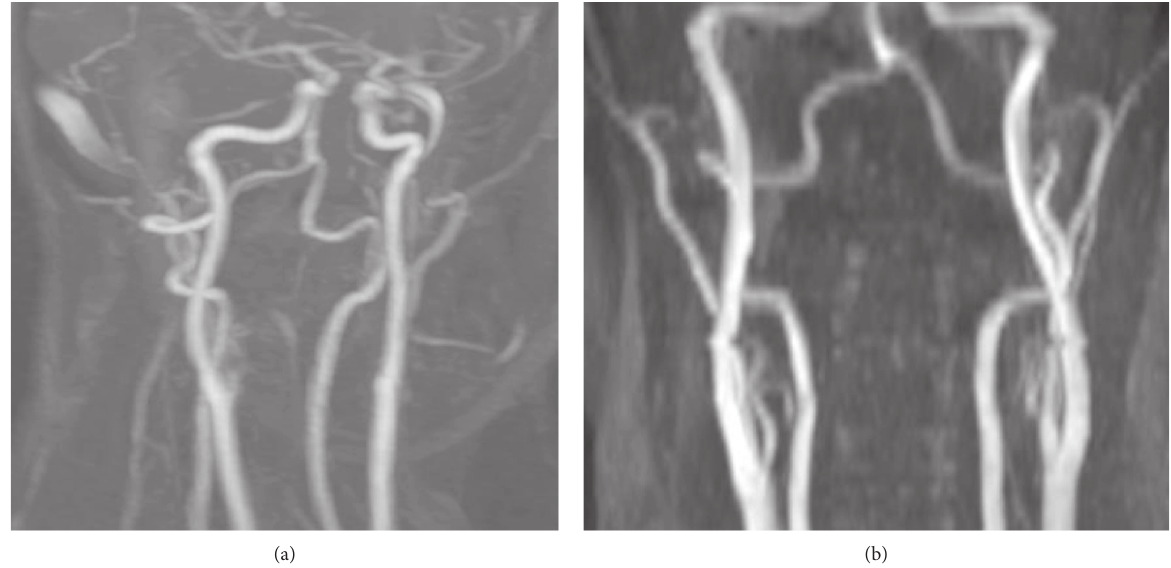
Figure 5: MR angiogram at 3-month follow-up showed complete resolution of bilateral